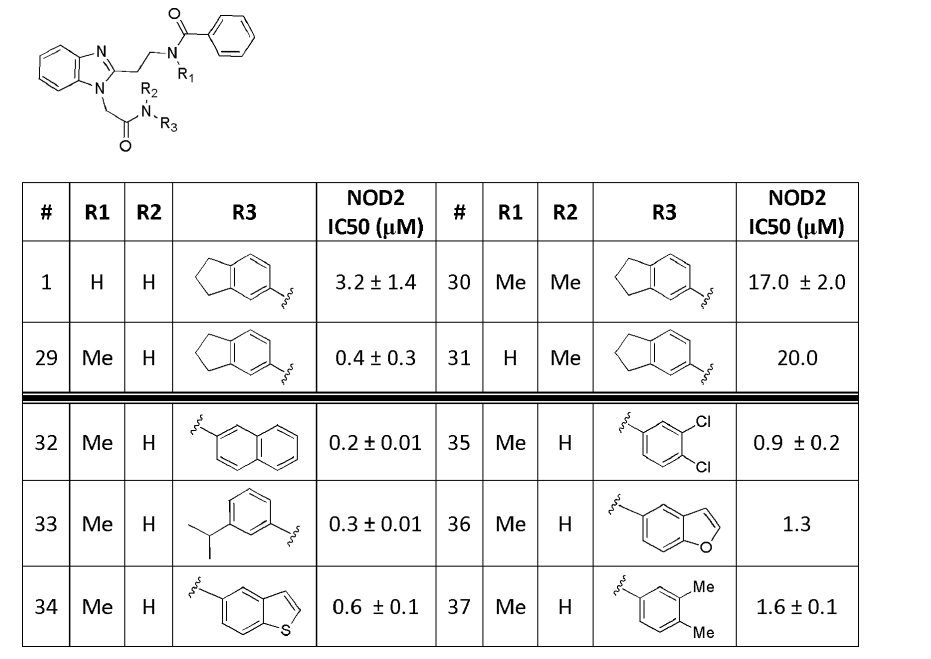
Figure 5. Structure-activity relationship for N-methyl analogs in the MDP-stimulated IL-8 production assay in 293/hNOD2 cells.